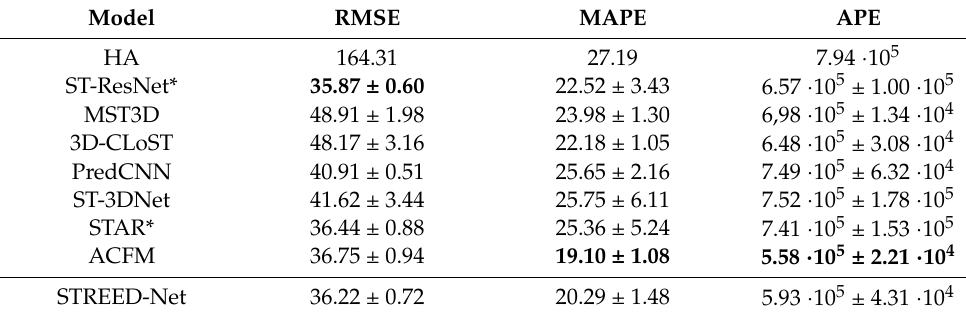
Table 3. Results obtained for the Taxi New York data